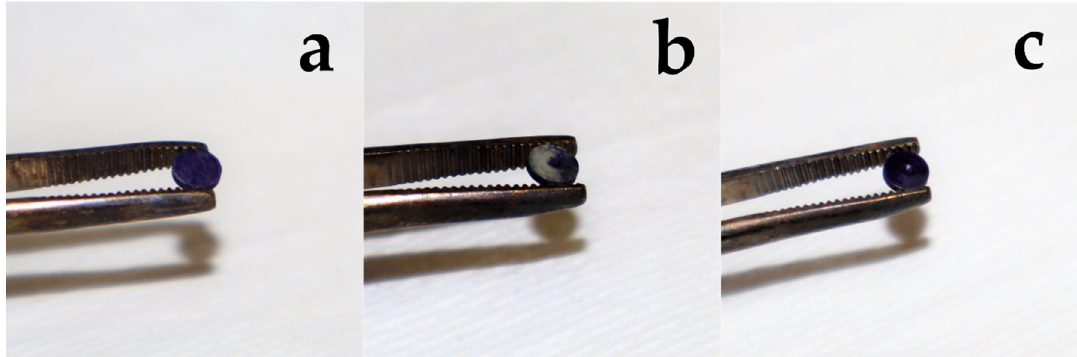
Figure 5. Crystal violet stained biofilm at the disc’s surface. ( a ) Roughened surface completely covered but also ( b ) mild and ( c ) strong biofilm formation at the smoother surface was observed.